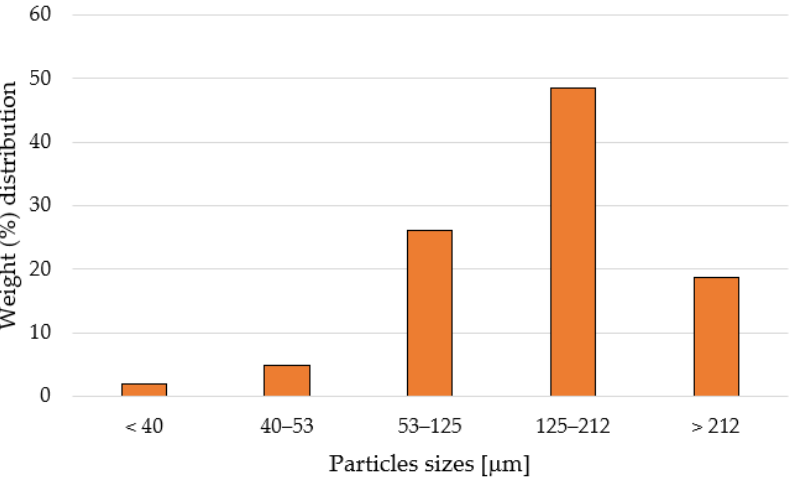
Figure 4. Particles size distribution for catalyst sample after milling. Table 2. Factors and levels for Pd and Pt recovery from SAC. Factors